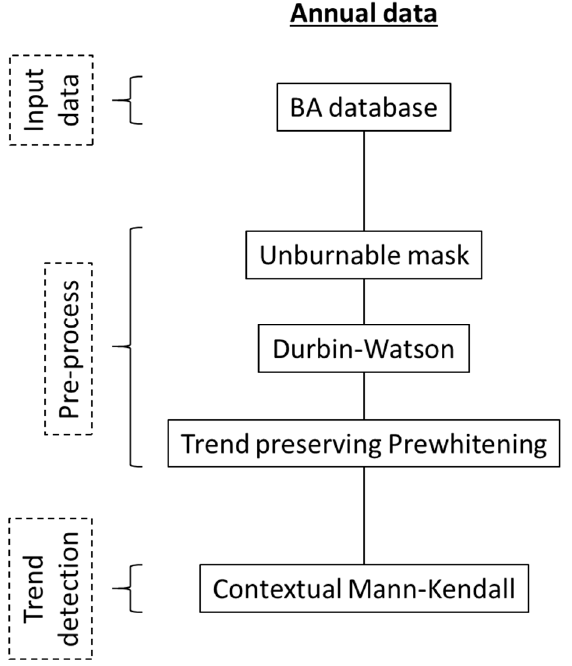
Figure 1. Outline of the methodology used to process the FireCCILT11 and FireCCI51 data.